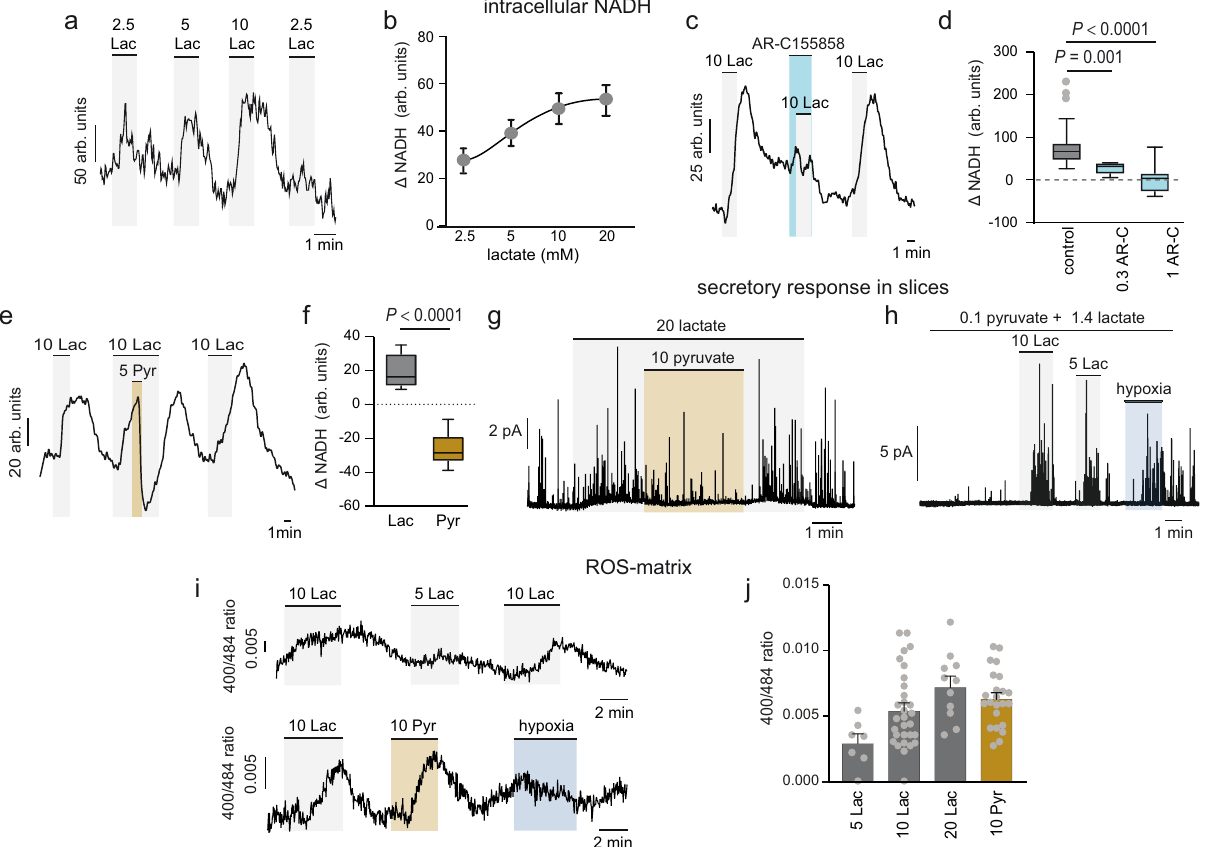
Fig. 4 Lactate-induced intracellular NADH and ROS signals. a , b Increase in NAD(P)H auto fl uorescence ( Δ NADH) induced by lactate (Lac in mM, gray) in dispersed glomus cells. Average values (mean ± SEM) in ( b ) are from: 2.5 Lac ( n = 21 cells/6 mice); 5 Lac ( n = 27 cells/8 mice); 10 Lac (28 cells/7 mice); 20 Lac ( n = 25 cells/4 mice). c Reversible blockade of a lactate (10 mM, gray)-induced rise in intracellular NADH ( Δ NADH) by MCT inhibition